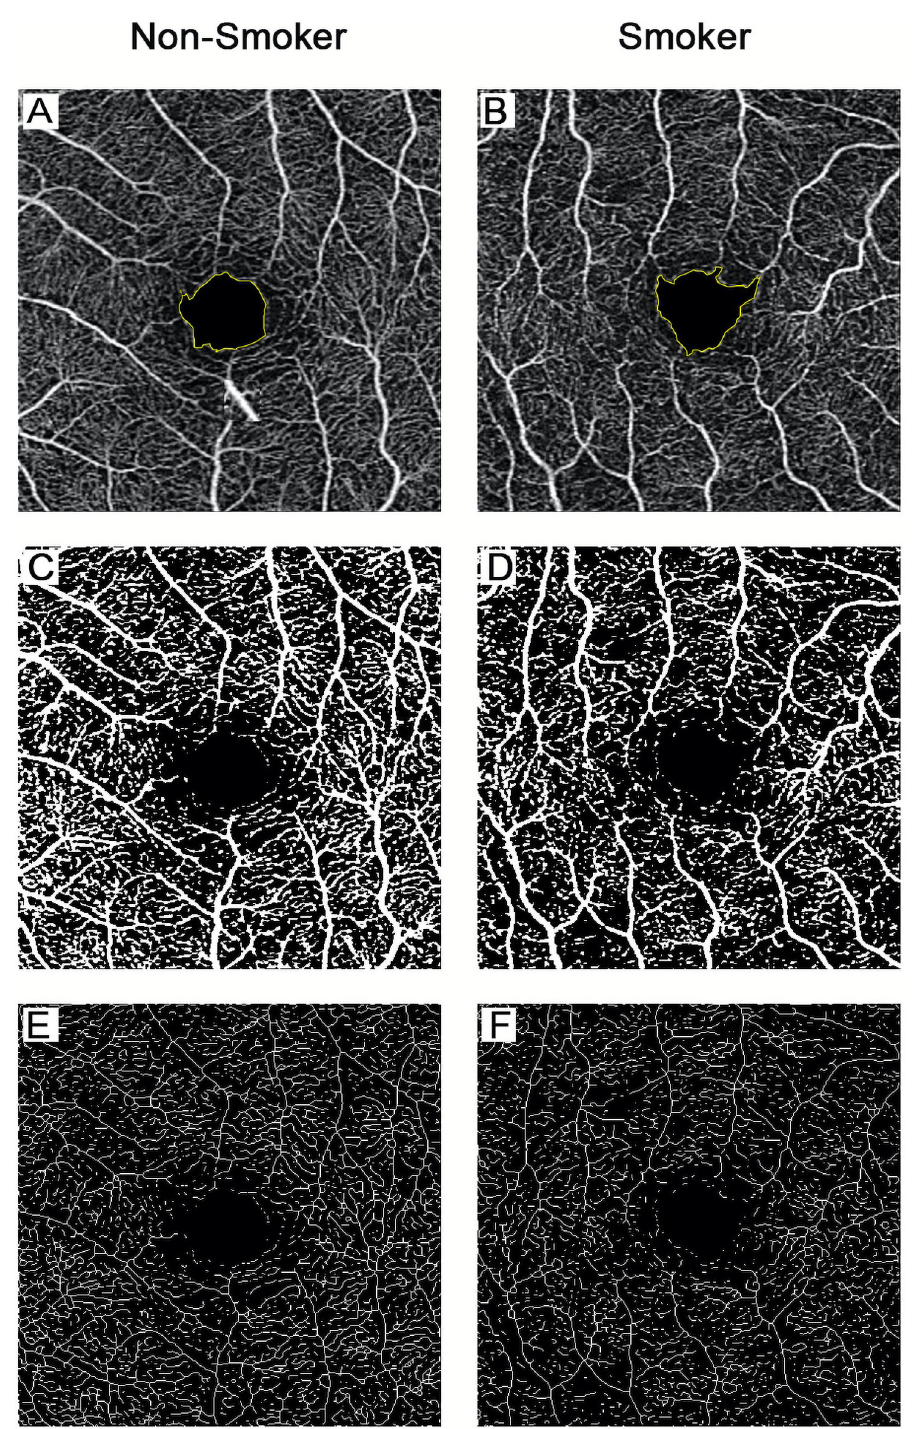
Fig 1. Optical coherence tomography (OCTA) image acquisition from SCP for each group. The FAZ was automatically delineated by the software (A, B). The perfused vasculature was automatically segmented by the software to calculate PD (C, D). The skeletonized vasculature was automatically segmented by the software to calculate VLD (E, F). Each column shows a representative subject from each group of participants. SCP = superficial capillary plexus, FAZ = foveal avascular zone, PD = perfusion density, VLD = vessel length density.